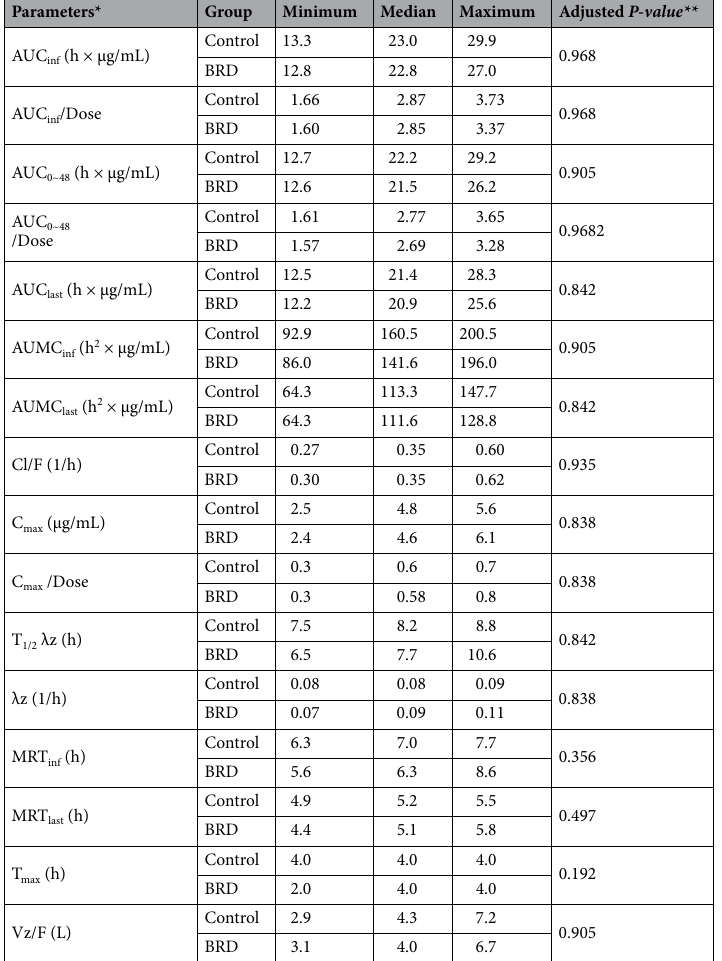
Table 1. The plasma pharmacokinetic parameters of danofloxacin administered to calves subcutaneously (8 mg/kg body weight, ten animals in each group) computed by a non-compartmental (i.e., statistical moments) analysis. * PK-parameters area under the curve from the time of dosing extrapolated to infinity (AUC inf ), area under the curve from the time of dosing to the last sampling time point (AUC 0~48 ), area under the curve from the time of dosing to the last measurable positive concentration (AUC last ), area under the first moment curve extrapolated to infinity (AUMC inf ), area under the first moment curve from dosing to the last measurable concentration (AUMC last ), apparent clearance (CL/F), maximum observed concentration (C max ), mean residence time from the time of dosing to the last measurable concentration (MRT last ), time to the maximum concentration (T max ), terminal half-life (T 1/2 λz), elimination rate (λz), and apparent volume of distribution associated with the terminal phase (Vz/F). Groups control—healthy control calves, and BRD— M. haemolytica infected calves. **Mann–Whitney test was used to compare the difference between the control and BRD